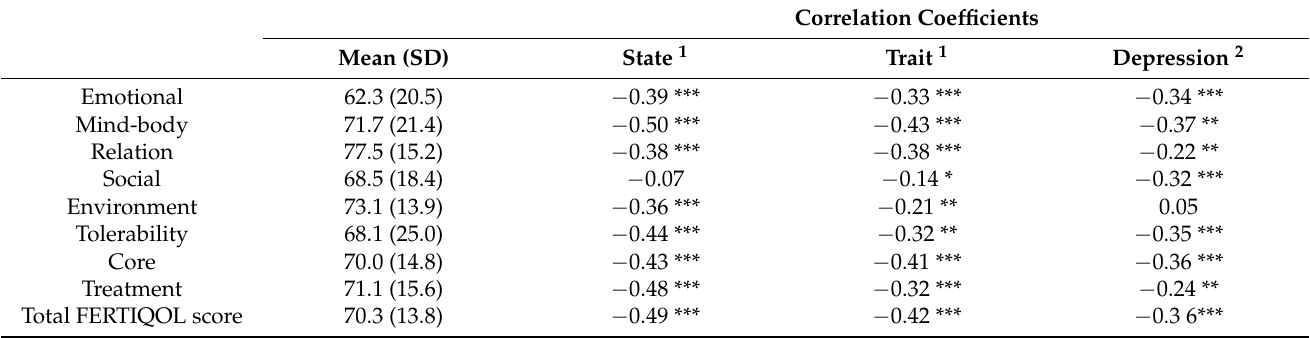
Table 2. Descriptive statistics of FERTI-QoL scales and their correlations with anxiety and depression